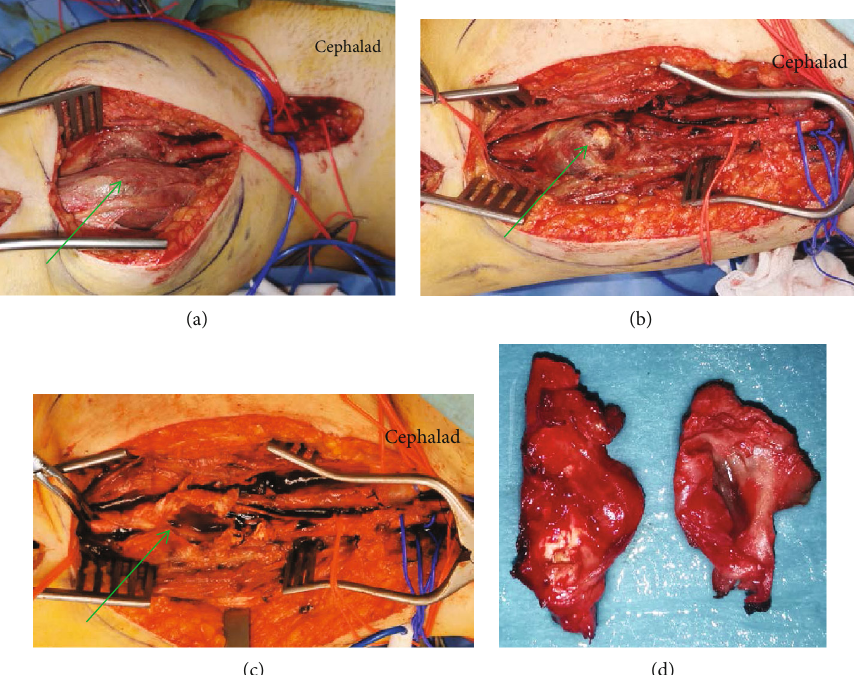
Figure 2: (a) Arrow indicates intramuscular pseudoaneurysm. (b) Arrow indicates ulcerated portion of pseudoaneurysm. (c) Arrow indicating turbid fl uid from mycotic pseudoaneurysm. (d) Excised pseudoaneurysm which was con fi rmed as a mycotic pseudoaneurysm on histopathological examination.